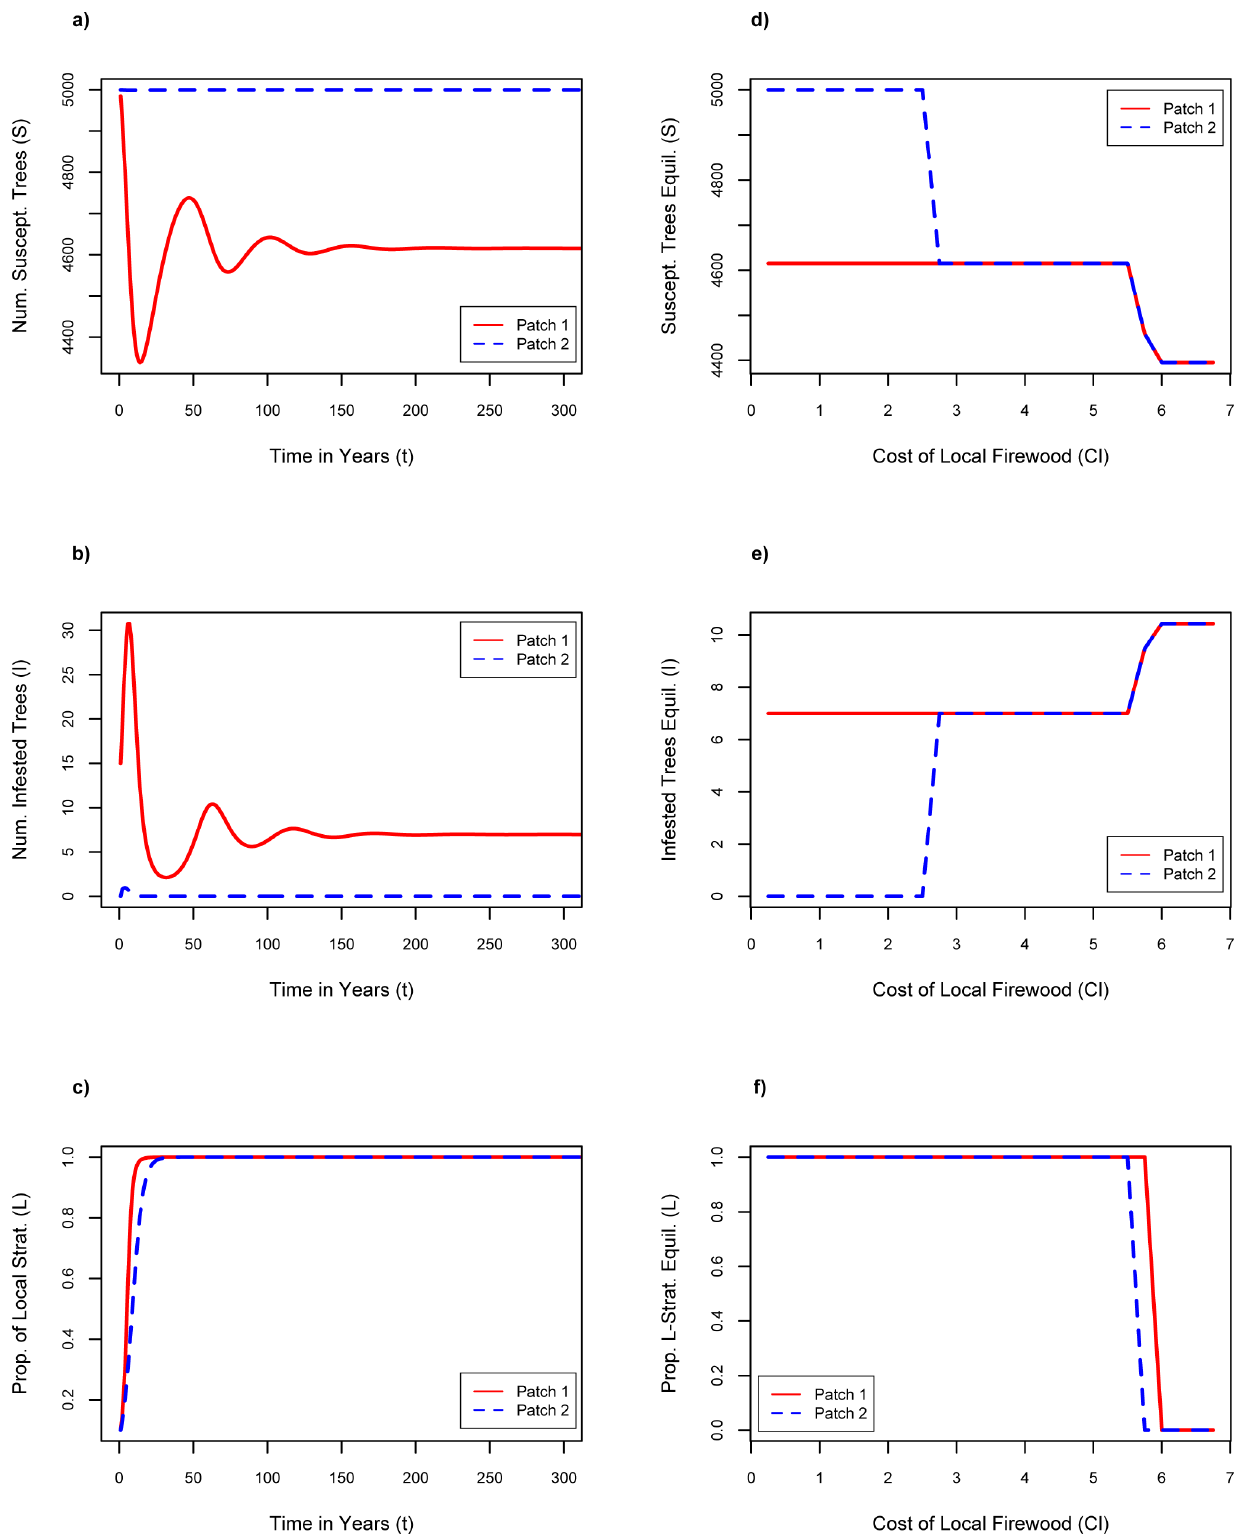
Figure 5. Results of decreasing cost of local firewood. Decrease cost of local firewood: n=0.1, f=1, s =0.1 where a) number of susceptible trees as a function of time with Cl= $ 2.25; b) number of infested trees as a function of time with Cl= $ 2.25; c) proportion of local firewood strategists as a function of time with Cl= $ 2.25; d) susceptible tree equilibria for increasing local firewood costs; e) infested tree equilibria for increasing local firewood costs; f) proportion of local firewood strategist equilibria for increasing local firewood costs.